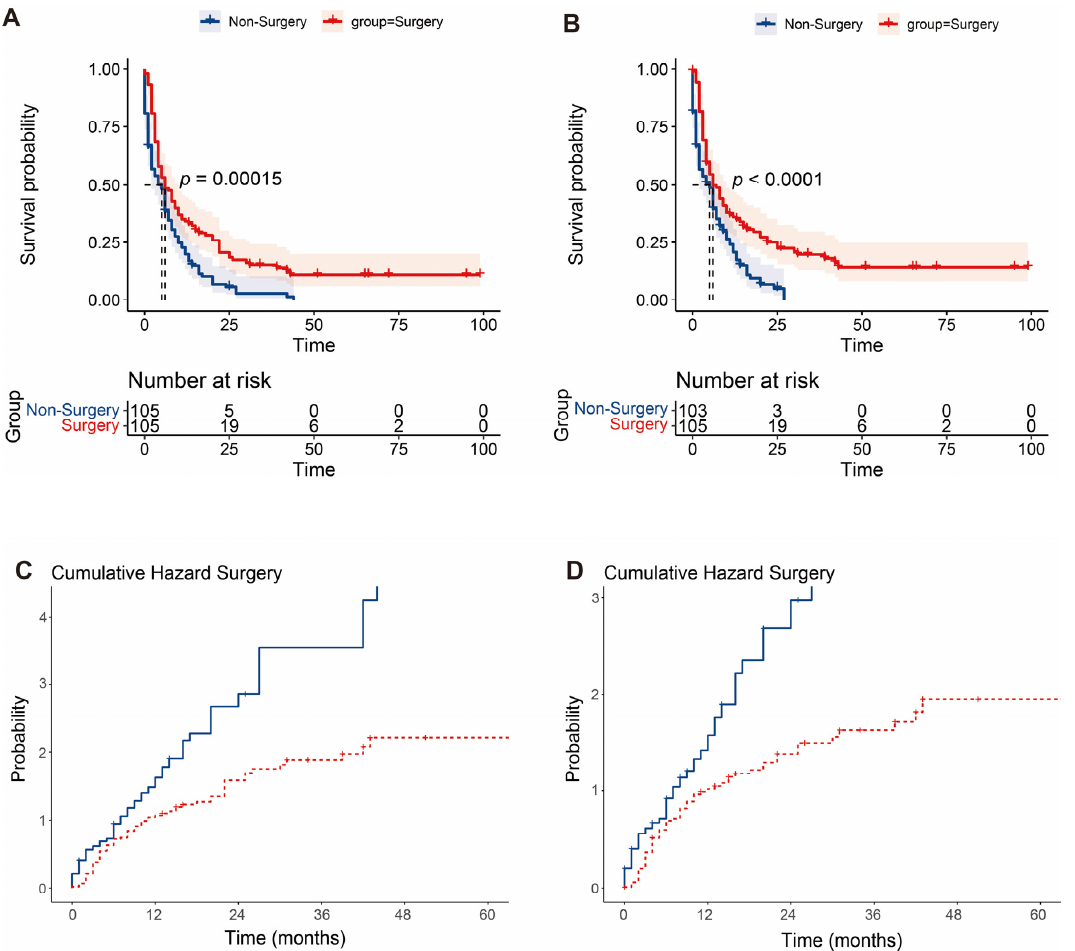
Figure 3. Survival analysis of no-surgery and surgery groups. The Kaplan–Meier analysis of overall survival ( A ) and cancer-specific survival ( B ) in two groups. Cumulative hazard concerning surgery of overall survival ( C ) and cancer-specific survival ( D ).